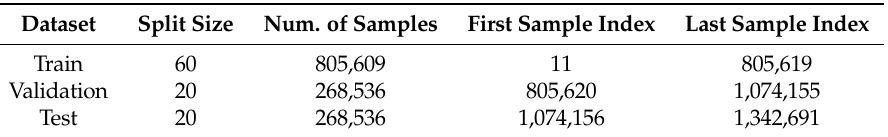
Table 2. Train-validation-test split